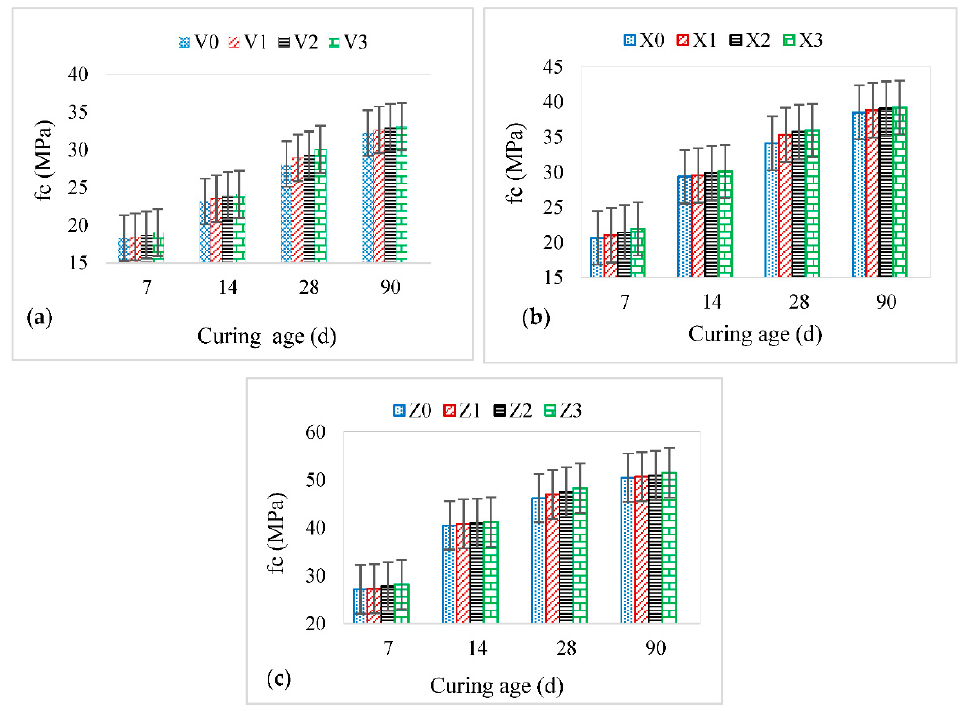
Figure 5. The results of compressive strengths for concrete grades ( a ) M 25, ( b ) M 30, and ( c ) M 40.